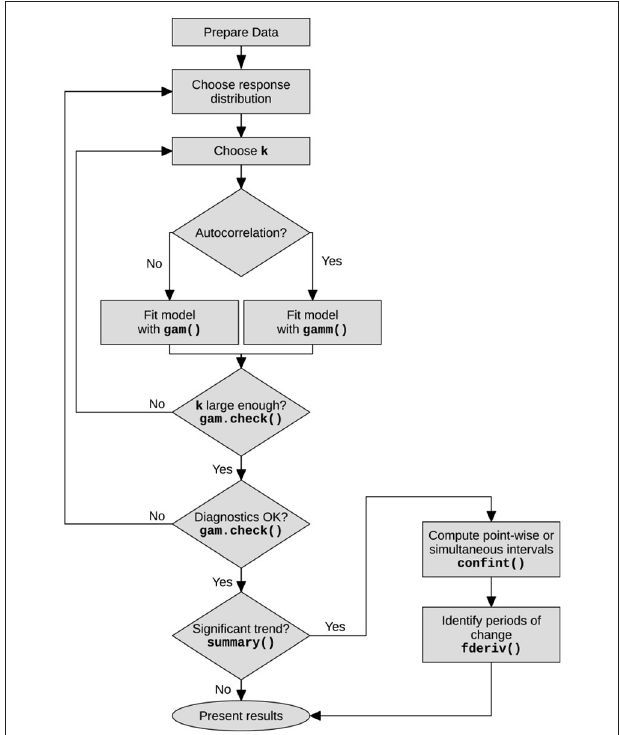
FIGURE 1 | Flowchart showing the main steps in the analysis of time series using generalised additive models. The main R functions associated with each step or decision are shown in